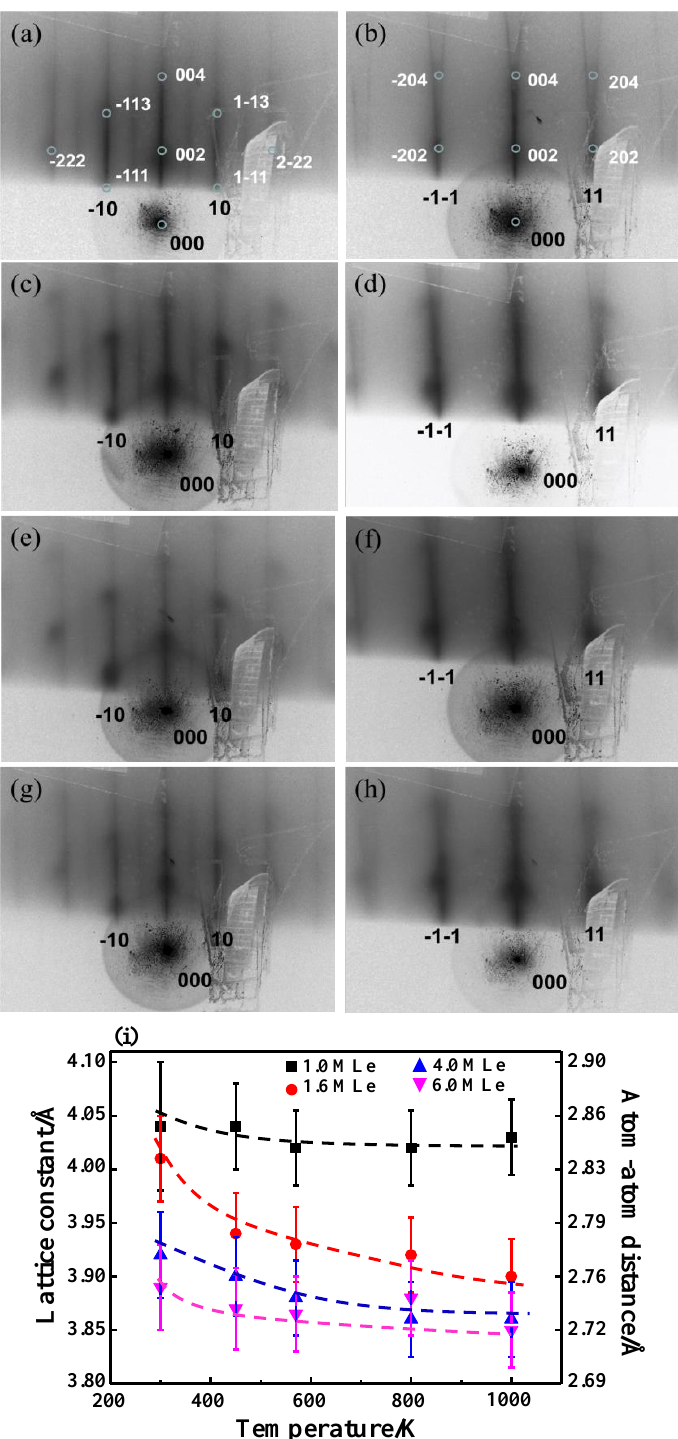
Figure 4. RHEED patterns for 1.6-MLe Rh clusters on Al 2 O 3 / NiAl(100) at ( a , b ) 300 K and annealed stepwise to ( c , d ) 450 K, ( e , f ) 570 K and ( g , h ) 800 K. ( a , c , e , g ) show patterns obtained at azimuth [0–10] of NiAl substrate, and ( b , d , f , h ) at azimuth [0–11]. Blue circles in ( a , b ) denote reciprocal-lattice points for the clusters of Rh(001)[110] // Al 2 O 3 (100)[010]. ( i ) plot of the lattice parameter of Rh clusters of varied sizes (coverages 1.0, 1.6, 4.0 and 6.0 MLe) as a function of temperature. The lattice parameters were derived by fitting the reciprocal-lattice nets to the di ff raction spots. The errors bars were obtained based on the reproducibility and the size of the di ff raction spots (the brightest areas, with top 2% in